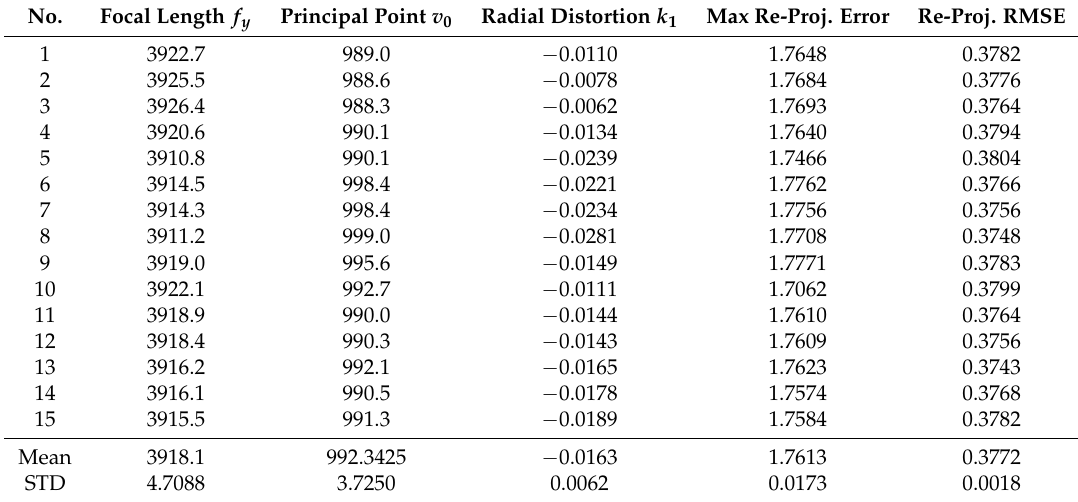
Table 2. Calibration results of the experimental data. The units of f y , v 0 , and re-proj errors are in